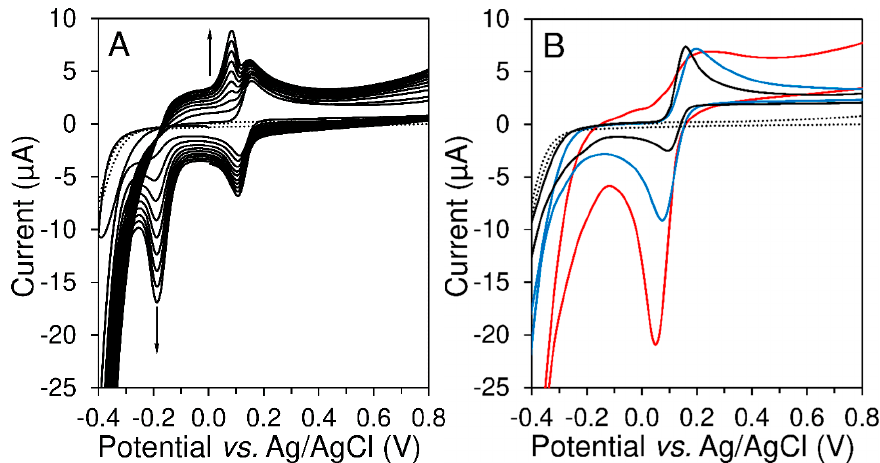
Figure 2. Repetitive ( n = 10) cyclic voltammograms of 500 µmol L − 1 Trolox, obtained at bare CPE ( A ) and cyclic voltammograms of 500 µmol·L − 1 Trolox obtained at bare CPE (black), CPE/MWCNTs (blue), and CPE/MWCNTs/TYR/Nafion ® (red curve) ( B ) in 0.1 mol·L − 1 PB of pH 7.0, E start = 0 V, E vertex1 = − 0.5 V, E vertex2 = +1.3 V, E step = 5 mV, v = 10 mV·s − 1 . Dotted black lines represent voltammograms obtained at CPE in 0.1 mol L − 1 PB (pH 7.0).